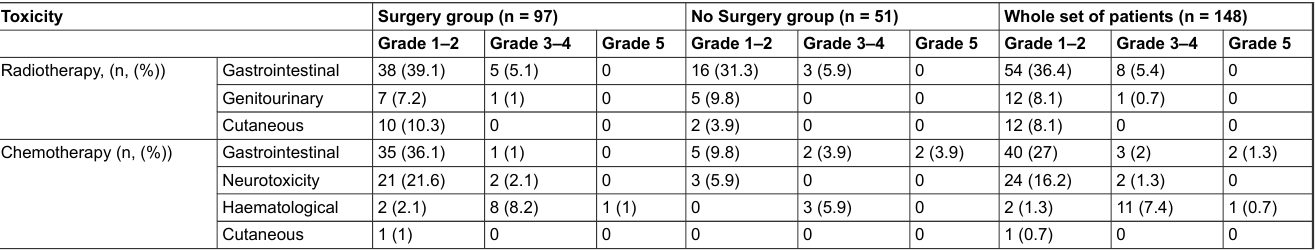
Table 2: Treatment toxicities.